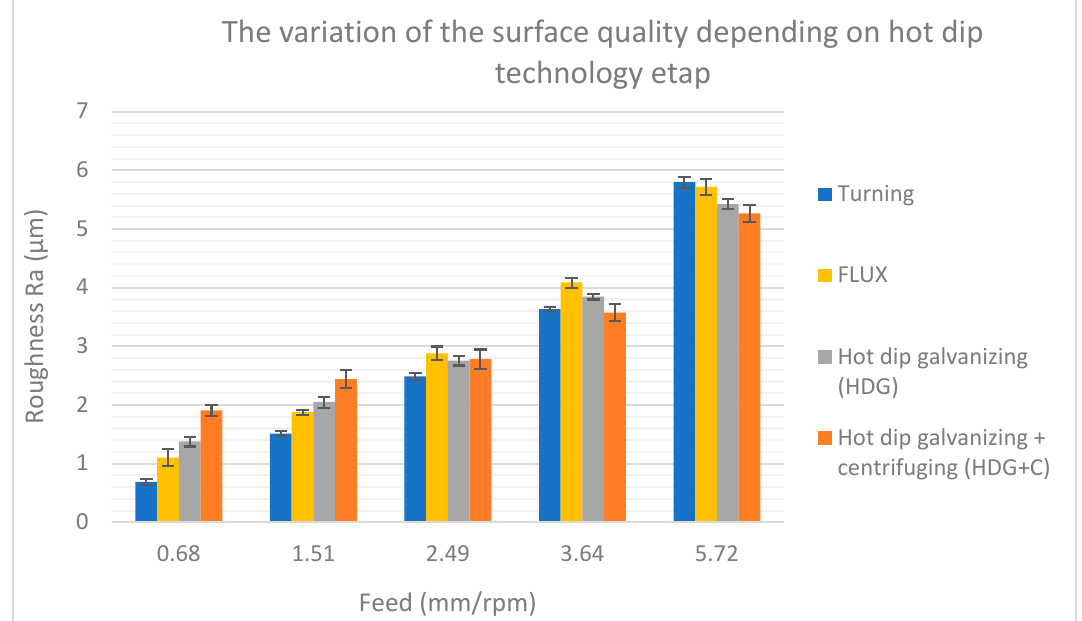
Figure 19. Variation in the surface roughness R a according to the phases of the galvanizing technology.